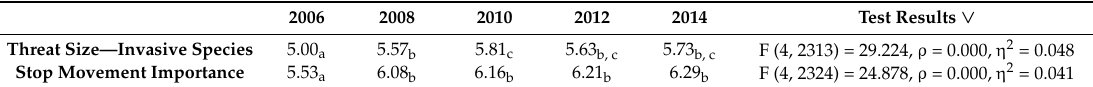
Table 2. Normative motivation †, ♦